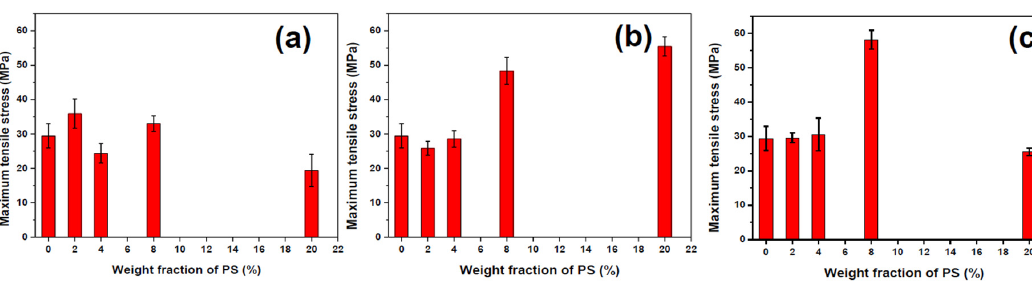
Figure 9. The maximum tensile stress of PS/PP blend fibers: ( a ) PS1/PP; ( b ) PS2/PP; ( c ) PS3/PP.